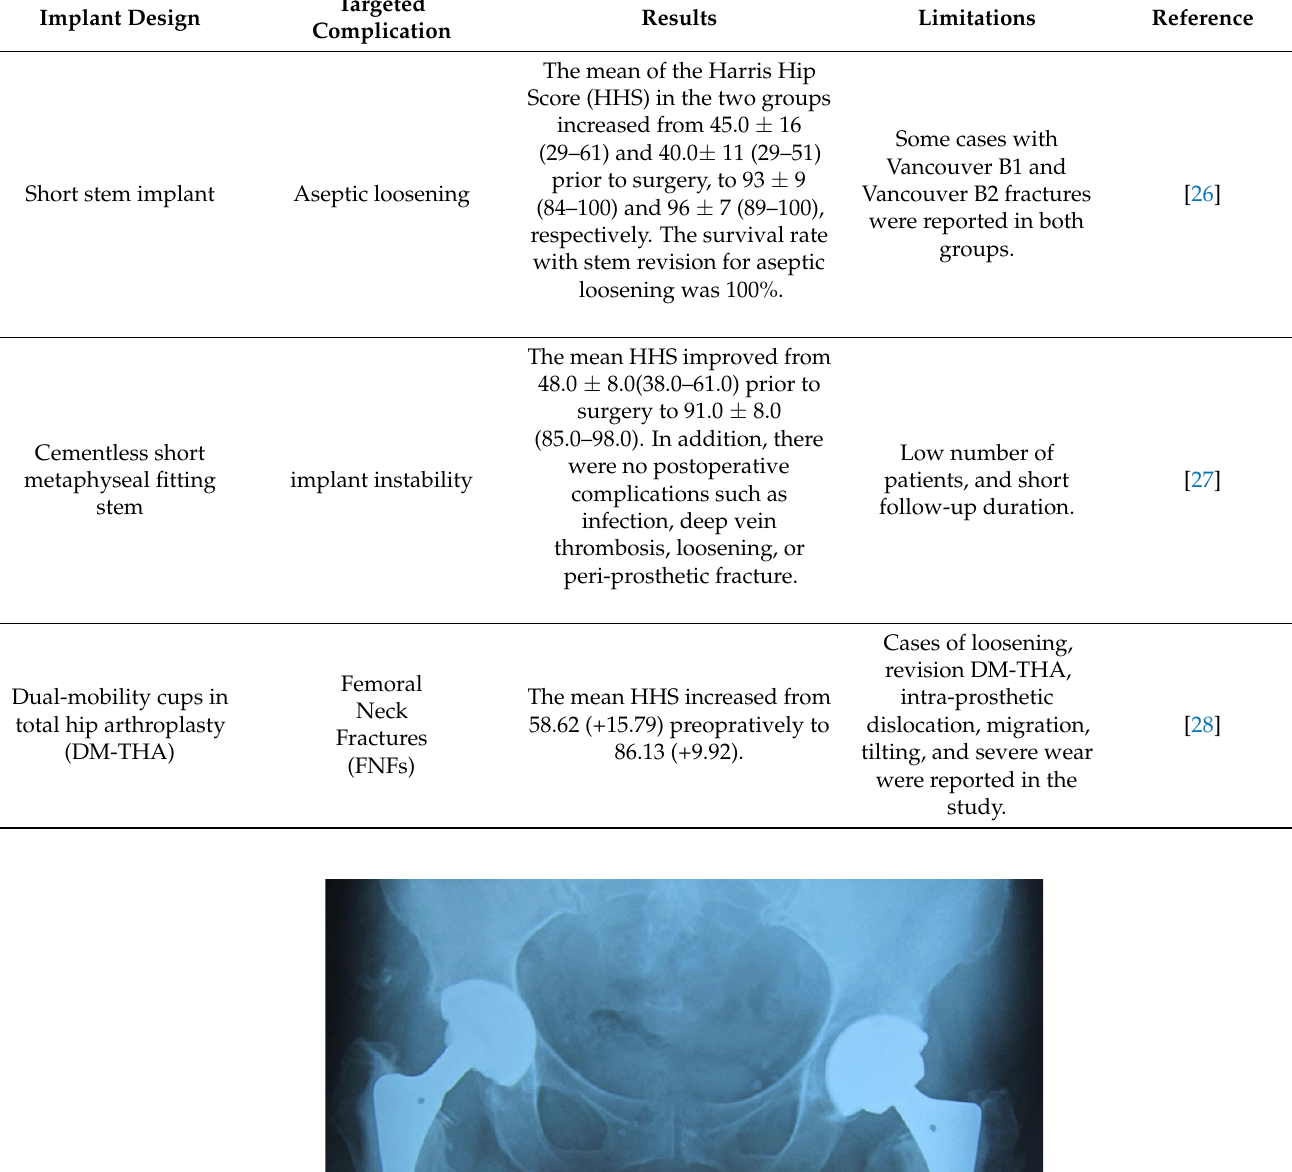
Table 4. Implant design optimisation.